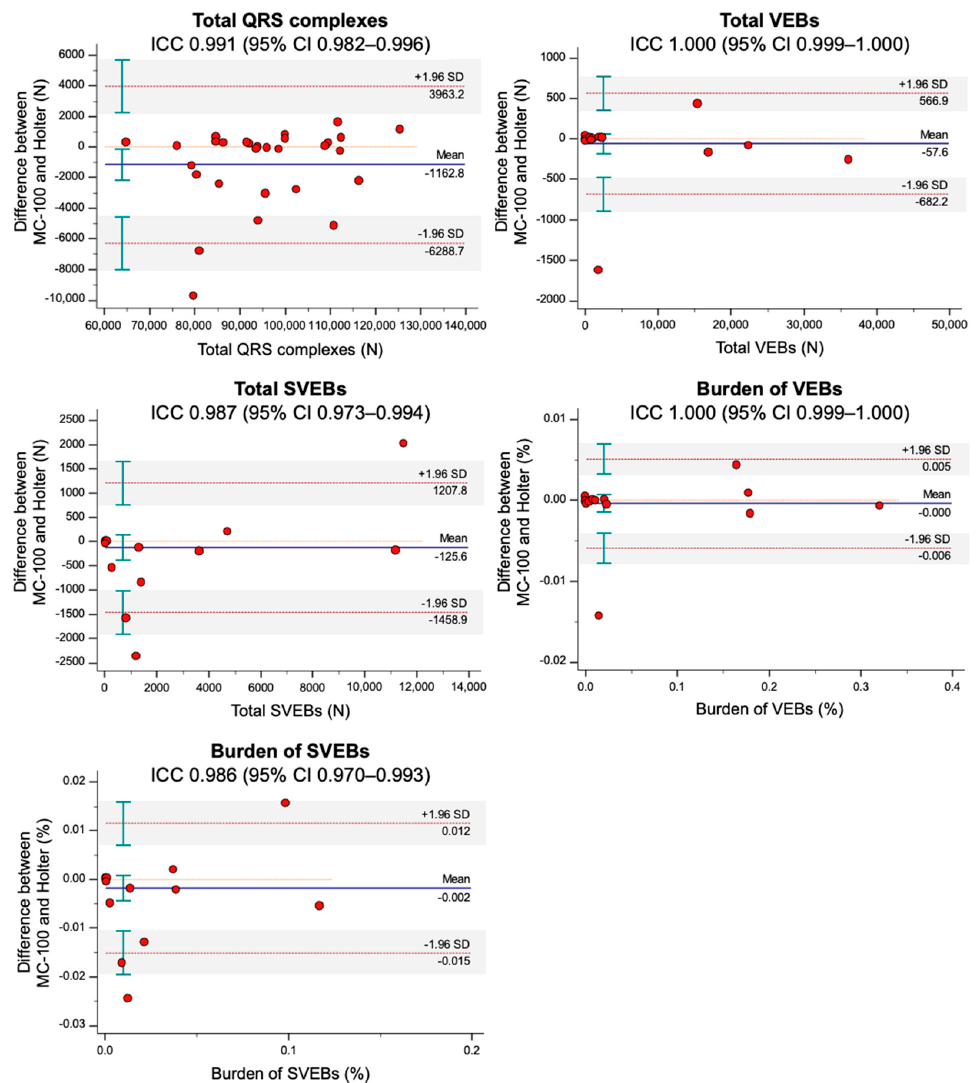
Figure 2. The Bland–Altman plots for ECG parameters, including total QRS complexes/VEBs/ SVEBs, and burdens of VEBs/SVEBs. The plots drew with 95% CI of limits of agreement and 95% CI of mean difference. The mobiCARE-MC100 served as a reference. Abbreviations: CI, confidence interval; ECG, electrocardiogram; ICC, intraclass correlation coefficient; SD, standard deviation; SVEB, supraventricular ectopic beat; VEB, ventricular ectopic